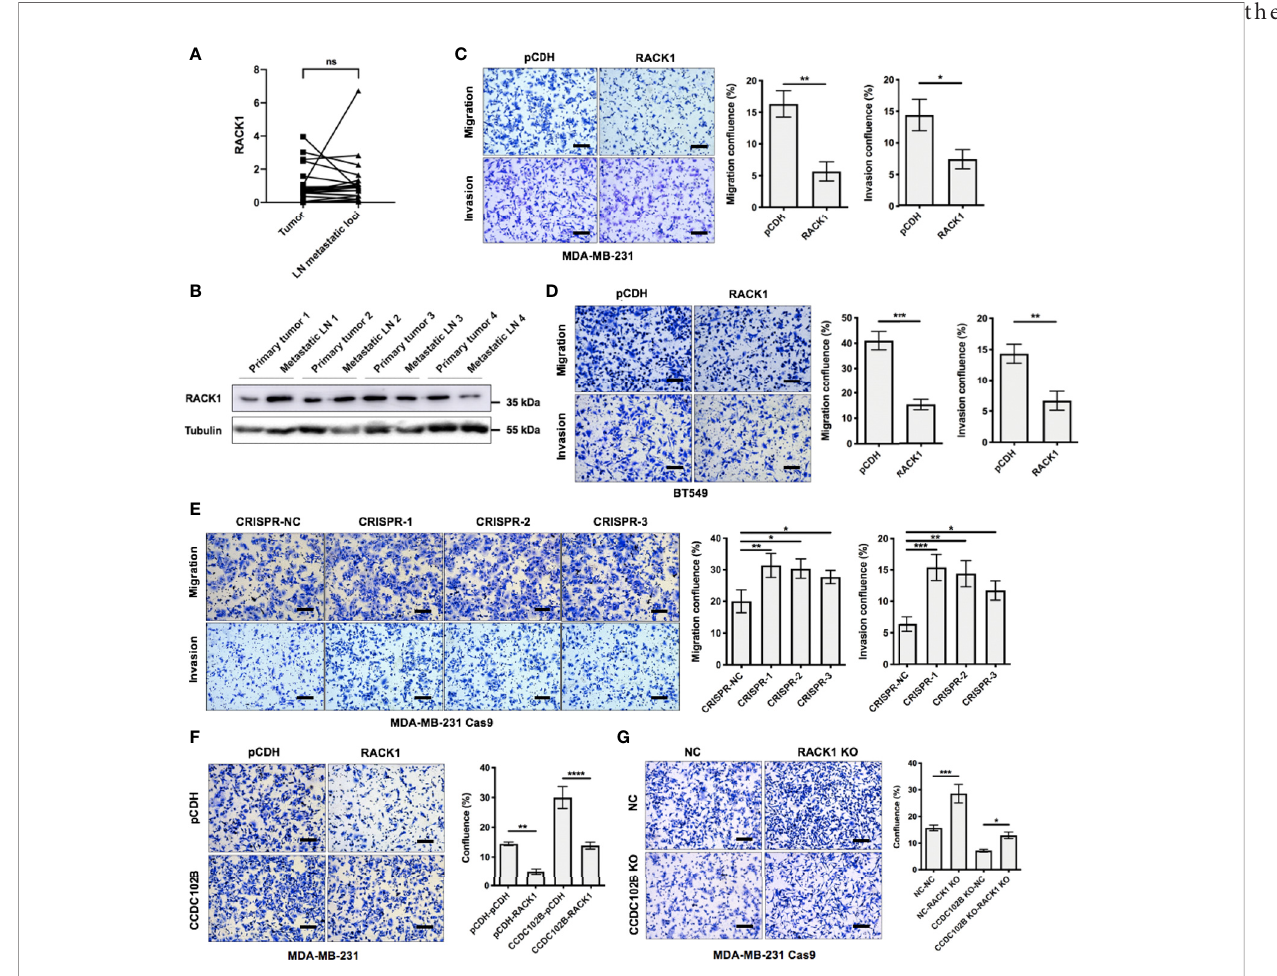
FIGURE 6 | RACK1 inhibits breast cancer metastasis. (A) Relative expression of RACK1 in primary breast cancer tissues (tumor) and their corresponding LN metastatic loci in a 20-paired-sample cohort (Wilcoxon matched-pairs signed rank test). Normalized to b -ACTIN. (B) Expression of RACK1 in primary tumors and corresponding metastatic LNs. (C, D) Transwell assay in MDA-MB-231 cells and BT549 cells. RACK1 overexpressed cells and the corresponding control cells were used. Representative photos and quantitative analysis were shown. Con fl uence of Transwell was analyzed by ImageJ. n=3, biological replicates. Scale bars: 100 m m. (E) Transwell assay in MDA-MB-231 Cas9 cells. RACK1 KO cells by CRISPR system and the corresponding control cells were used. Representative photos and quantitative analysis were shown. Con fl uence of Transwell was analyzed by ImageJ. n=3, biological replicates. Scale bars: 100 m m. (F, G) Cell functional rescue tests with Transwell assay in MDA-MB-231 cells and MDA-MB-231 Cas9 cells. CCDC102B overexpressed cells, RACK1 overexpressed cells, CCDC102B KO cells, RACK1 KO cells and the corresponding control cells were used. Representative photos and quantitative analysis were shown. Con fl uence of Transwell was analyzed by ImageJ. n=3, biological replicates. Scale bars: 100 m m. ns, P > 0.05; *P ≤ 0.05; **P ≤ 0.01; ***P ≤ 0.001; ****P ≤